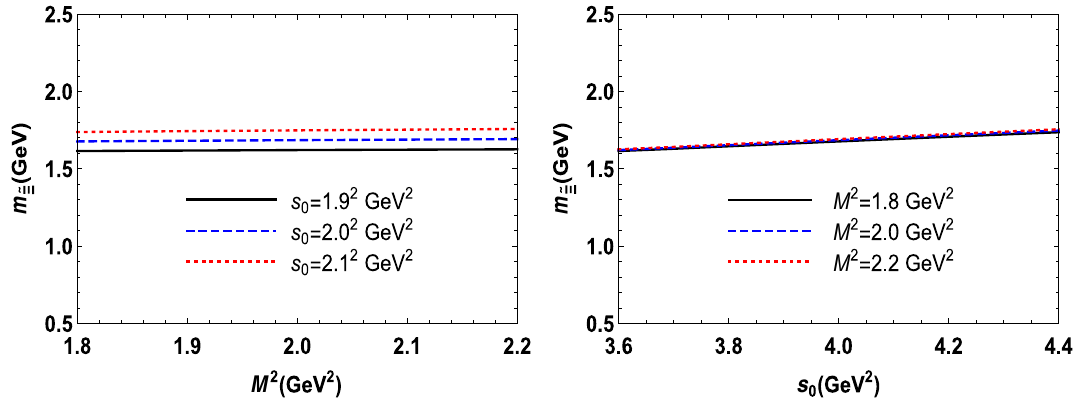
Fig. 1 The mass of the (cid:2) (cid:2) baryon as a function of the Borel parameter M 2 at chosen values of s 0 (left panel), and as a function of the continuum threshold s 0 at fixed M 2 (right panel) with β = 0 . 7